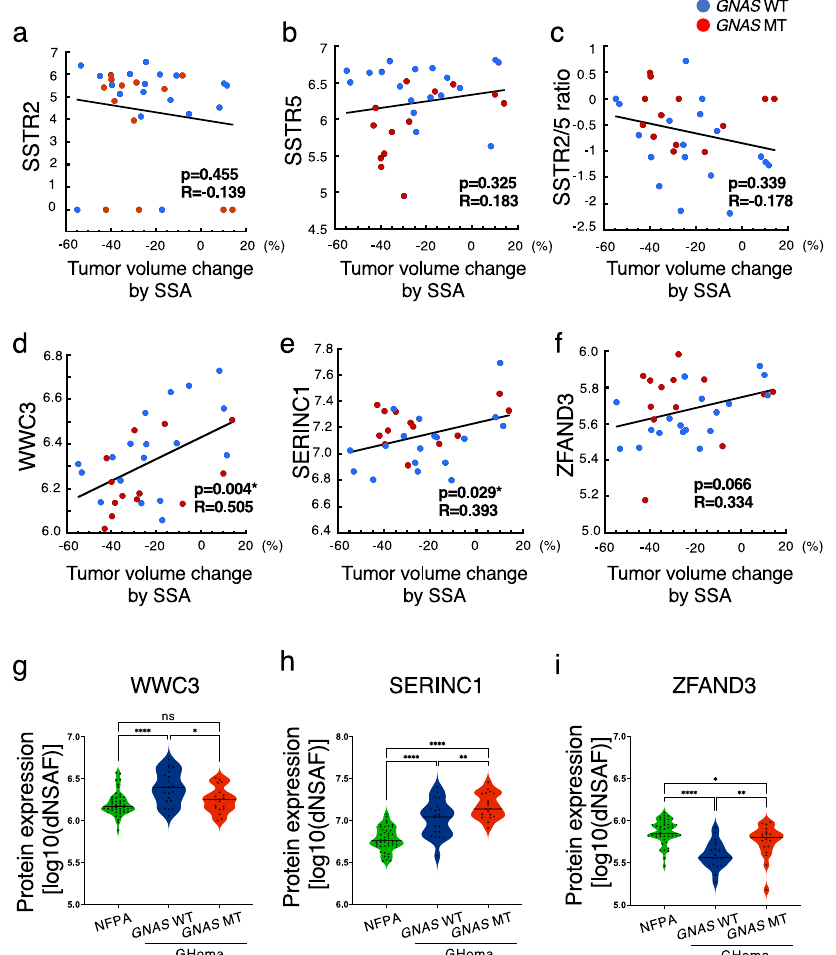
Fig. 6 Correlation between protein expression levels and tumor volume change rate in the SSA test. Correlations between ( a ) somatostatin receptor 2 (SSTR2) protein expression, ( b ) SSTR5 protein expression, ( c ) the SSTR2/5 ratio, ( d ) WWC family member 3 (WWC3) protein expression, ( e ) serine incorporator 1 (SERINC1) protein expression, and ( f ) zinc fi nger AN1-type containing 3 (ZFAND3) protein expression and the tumor volume change rate in the somatostatin analog (SSA) test (%). Data were analyzed by Pearson ’ s correlation analysis. g WWC3, ( h ) SERINC1, and ( i ) ZFAND3 protein expression levels in NFPA, GNAS -WT GHoma, and GNAS - MT GHoma. All protein expression values were log (base 10) transformed. NFPA: nonfunctional pituitary adenoma/non-functioning pituitary neuroendocrine tumor (PitNETs), GHoma: GH-producing pituitary adenoma/somatotroph Pituitary neuroendocrine tumor (PitNETs). * p < 0.05, ** p < 0.01, ****p < 0.0001 by 1-way ANOVA. a – f n = 18 in GHoma with GNAS WT, n = 13 in GHoma with GNAS MT. g – i n = 45 in NFPA, n = 21 in GHoma with GNAS WT, n = 19 in GHoma with GNAS